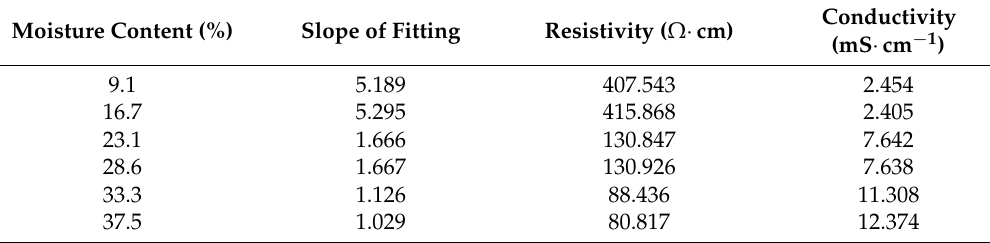
Figure 3. Linear fitting between R s and distance from air-cathode at different moisture contents of soil samples: ( a ) moisture content of 9.1%; ( b ) moisture content of 16.7%; ( c ) moisture content of 23.1%; ( d ) moisture content of 28.6%; ( e ) moisture content of 33.3%; ( f ) moisture content of 37.5%. Table 3. Conductivity and resistivity calculated from the linear fitting slope of R s and distance from air-cathode at different moisture contents of soil samples.